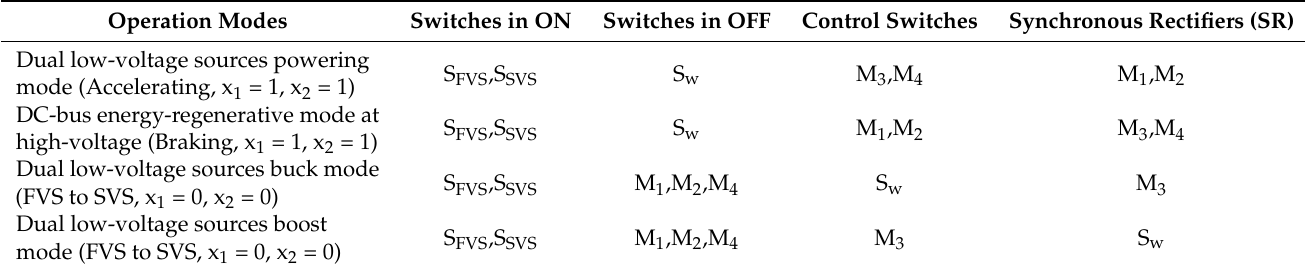
Table 1. Conduction status of devices for various operation